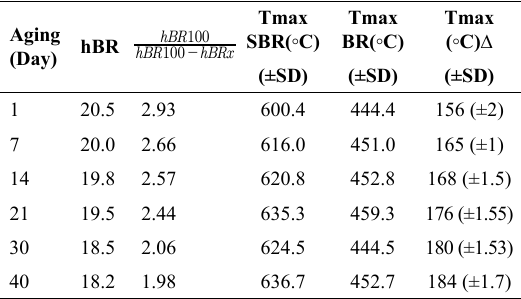
Figure 2. TG-DTG curve of BR100 aged for one day Table 4. Thermal properties of BR/SBR rubber specimens aged for different